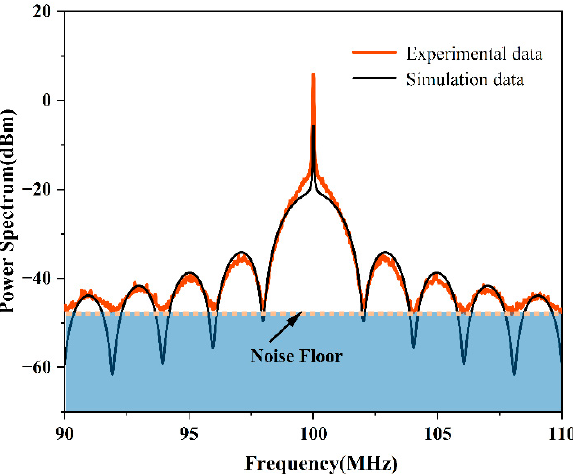
Figure 6. Plots showing the impact of the noise floor measurement and the resultant differences between the simulated and experimental data.